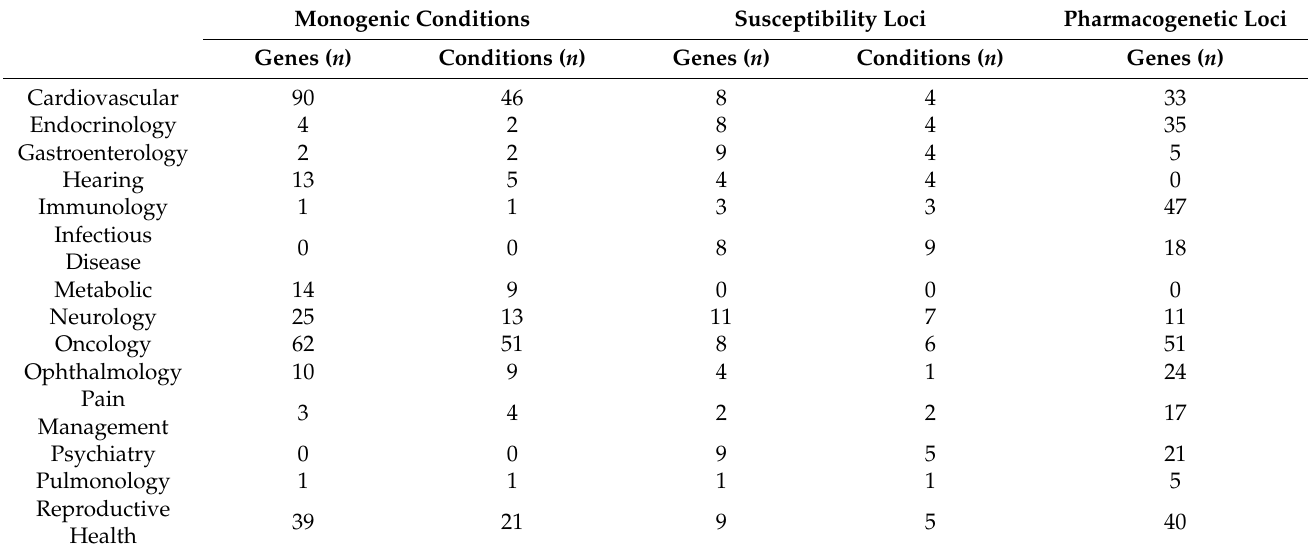
Table 1. GeneCompass clinical panel